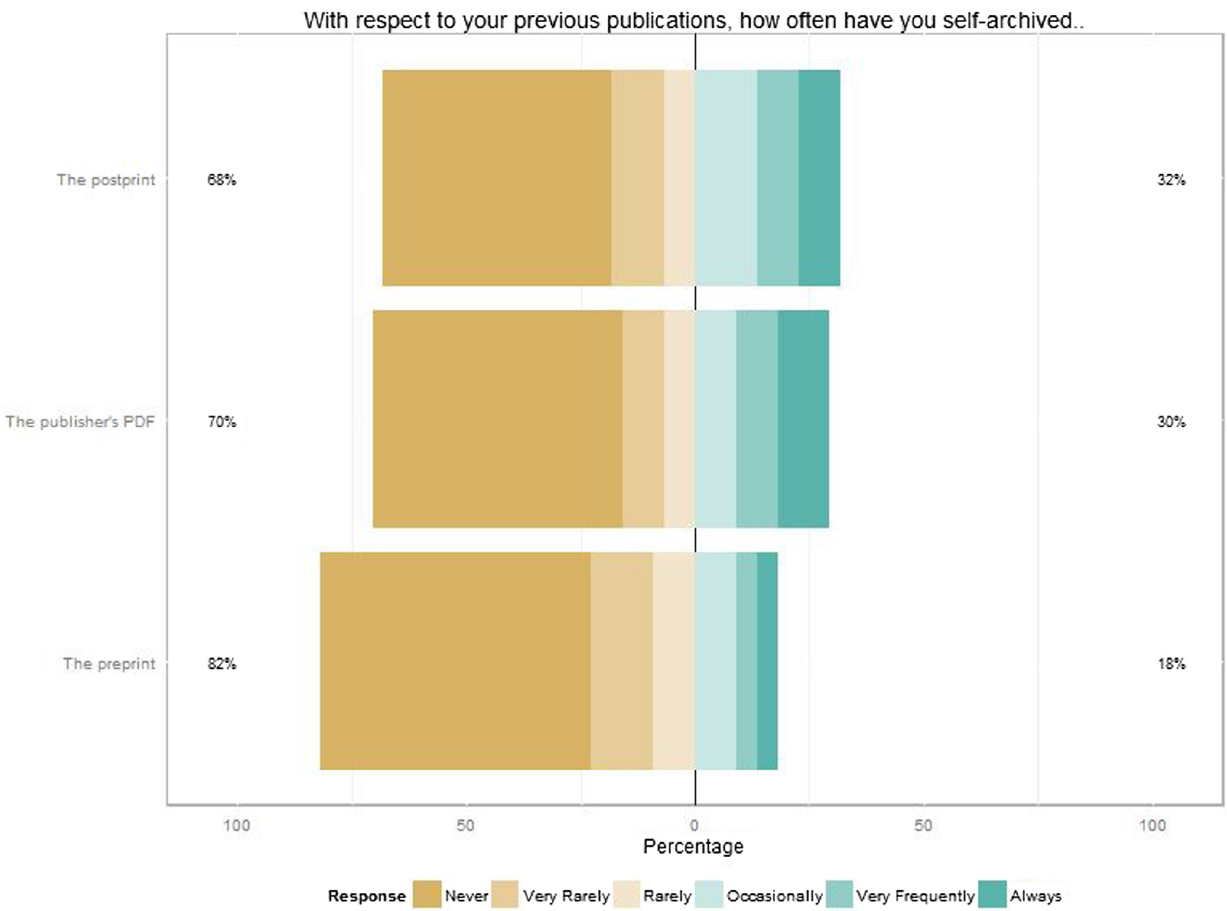
Figure 4. Answers to the question: With respect to your previous publications, how often have you self-archived a preprint, a postprint, and the publisher ’ s